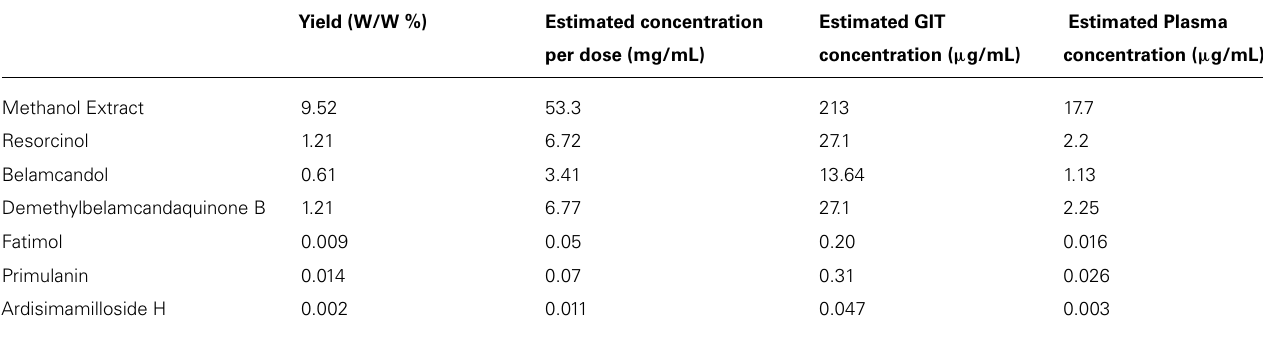
Table 2 | Calculation of estimated extract per dose, GIT and plasma concentrations of KF methanol extract and its constituents. Yield (W/W %) per dose (mg/mL)